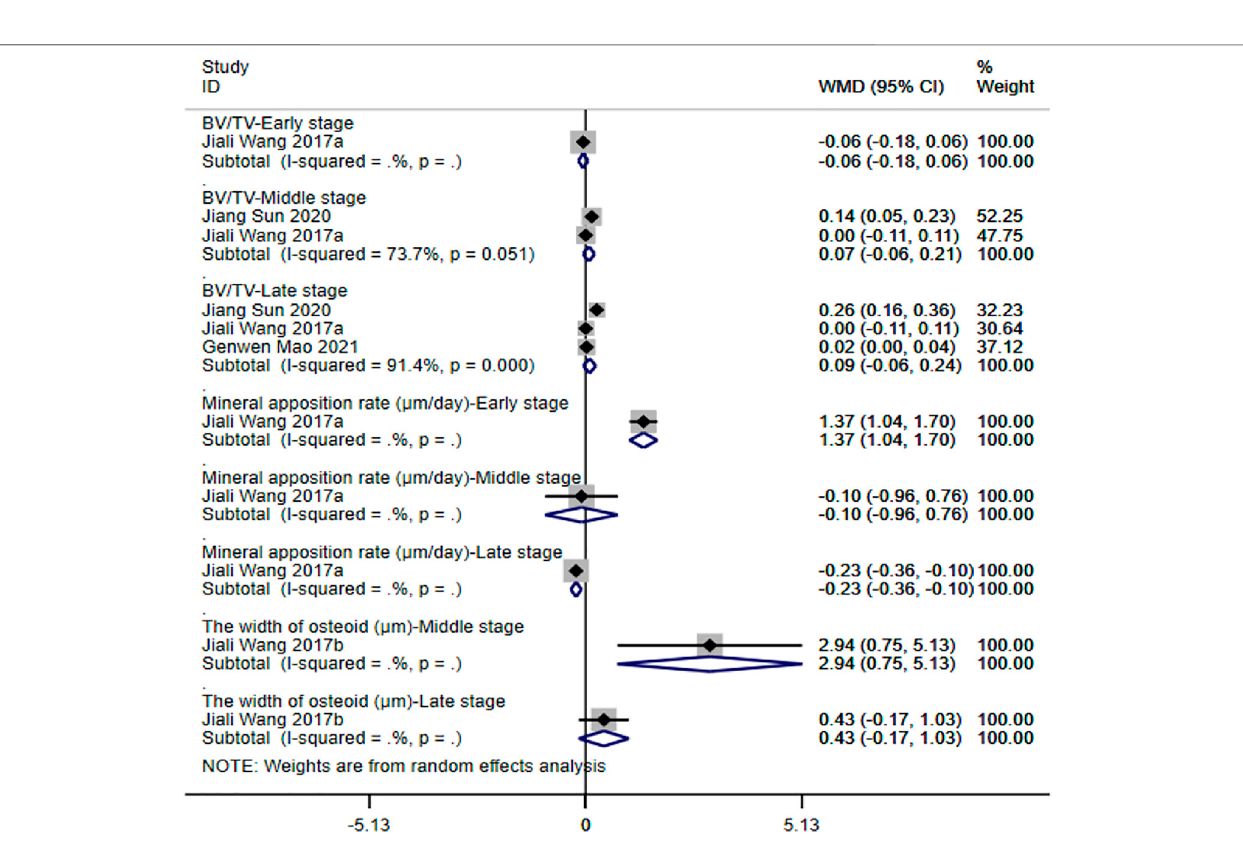
Frontiers in Bioengineering and Biotechnology |